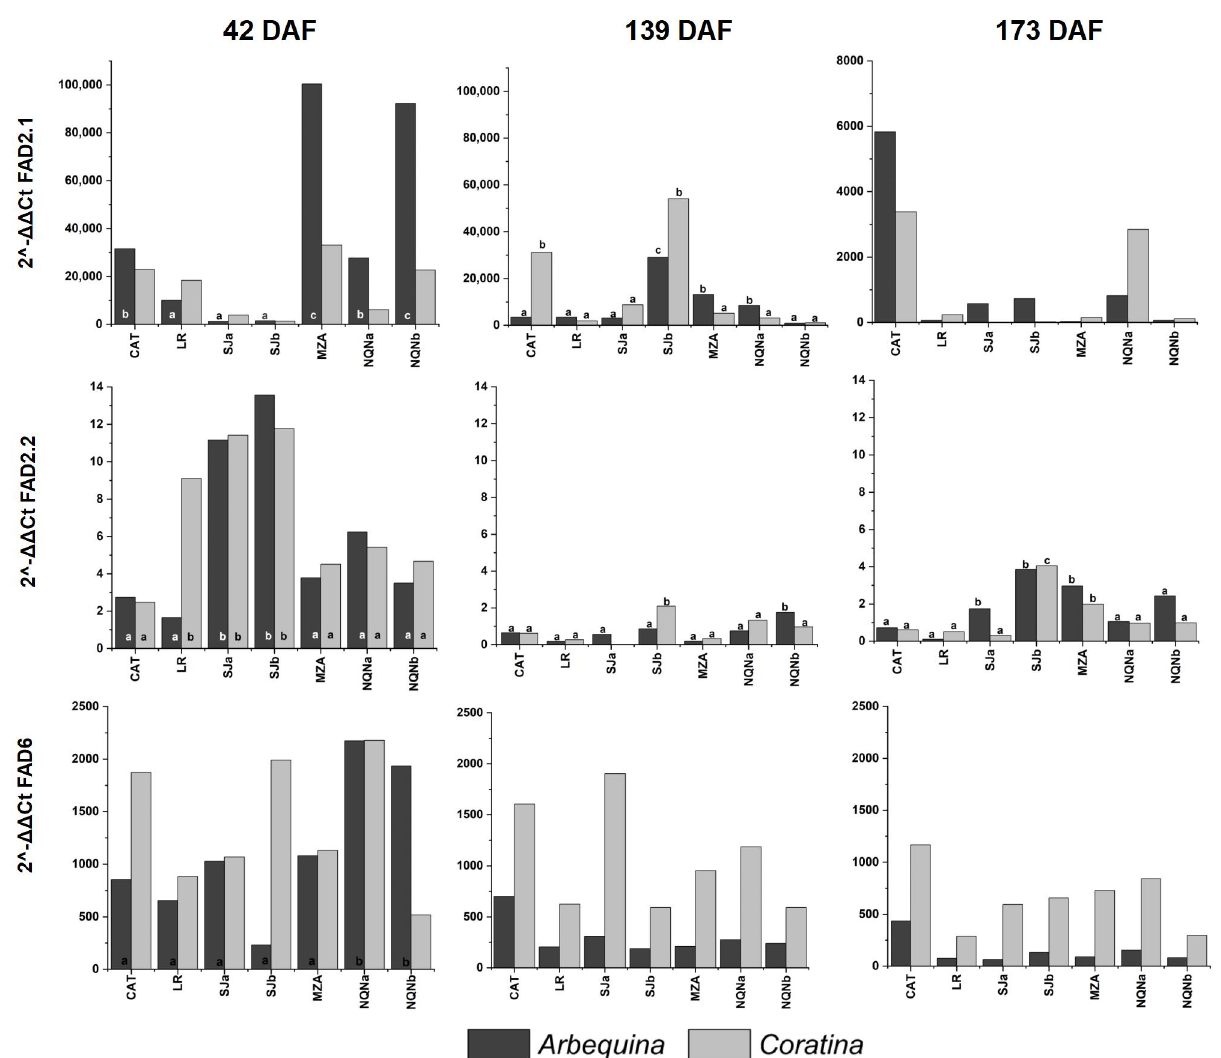
Figure 4. Expression of the OeFAD gene family during three fruit phenological stages (42, 139 and 173 days after full flowering (DAF)) in cvs. Arbequina and Coratina in the seven analyzed growing environments (Catamarca (CAT) 2014/15; La Rioja (LR), 2015/16; San Juan (SJa), 2014/15; San Juan (SJb), 2015/16; Mendoza (MZA), 2015/16; Neuquén (NQNa), 2014/15; and Neuquén (NQNb), 2015/16). Different letters correspond to significant differences at p < 0.05 among environments for a given phenological stage.